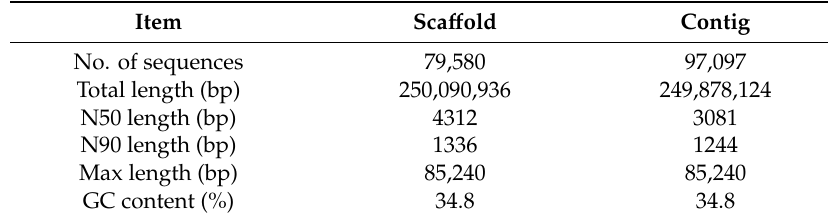
Table 4. Statistics of assembled B. platyphylla genome sequences.